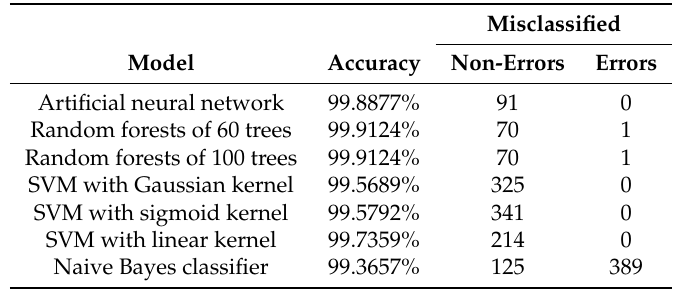
Table 7. Accuracy of error classification in wheat using various ML-based